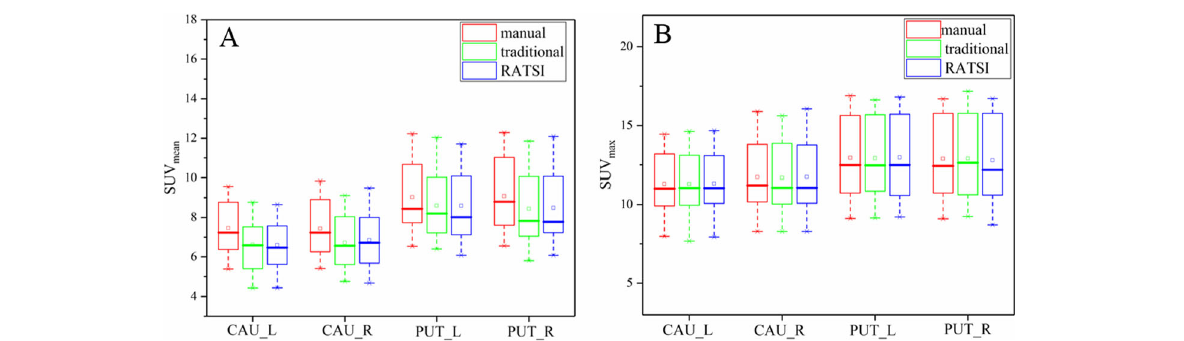
Fig. 5 The boxplots displaying the distribution of the SUV mean ( a ) and SUV max ( b ) in caudate nucleus (left: CAU_L, right: CAU_R) and putamen (left: PUT_L, right: PUT_R) from twenty PD patients with manual segmentation (red), the RSIAT method (green), and RATSI (blue)